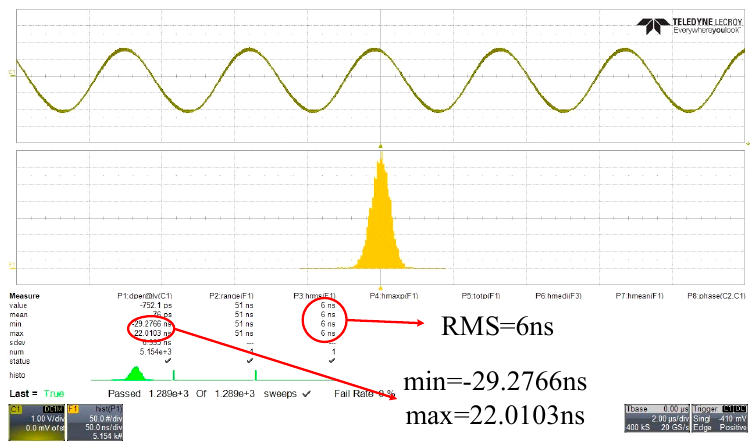
Figure 21. The measured phase noise of the proposed oscillator of V o 1 .